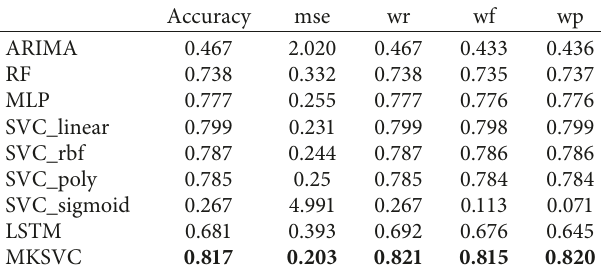
Table 14: Performance comparison for predicting the future 6 hour’s PM2.5 IAQL in Beijing.